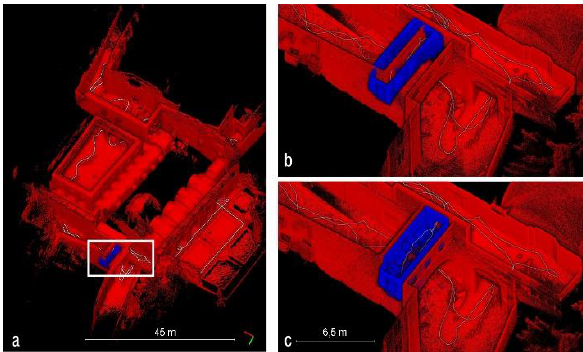
Figure 7. SLAM-based point cloud (red) and its trajectory (white) with highlighted auxiliary room (blue): (a) acquired data, (b) focus on the misalignment of the room in the raw point cloud, (c) data obtained after reprocessing and merge.